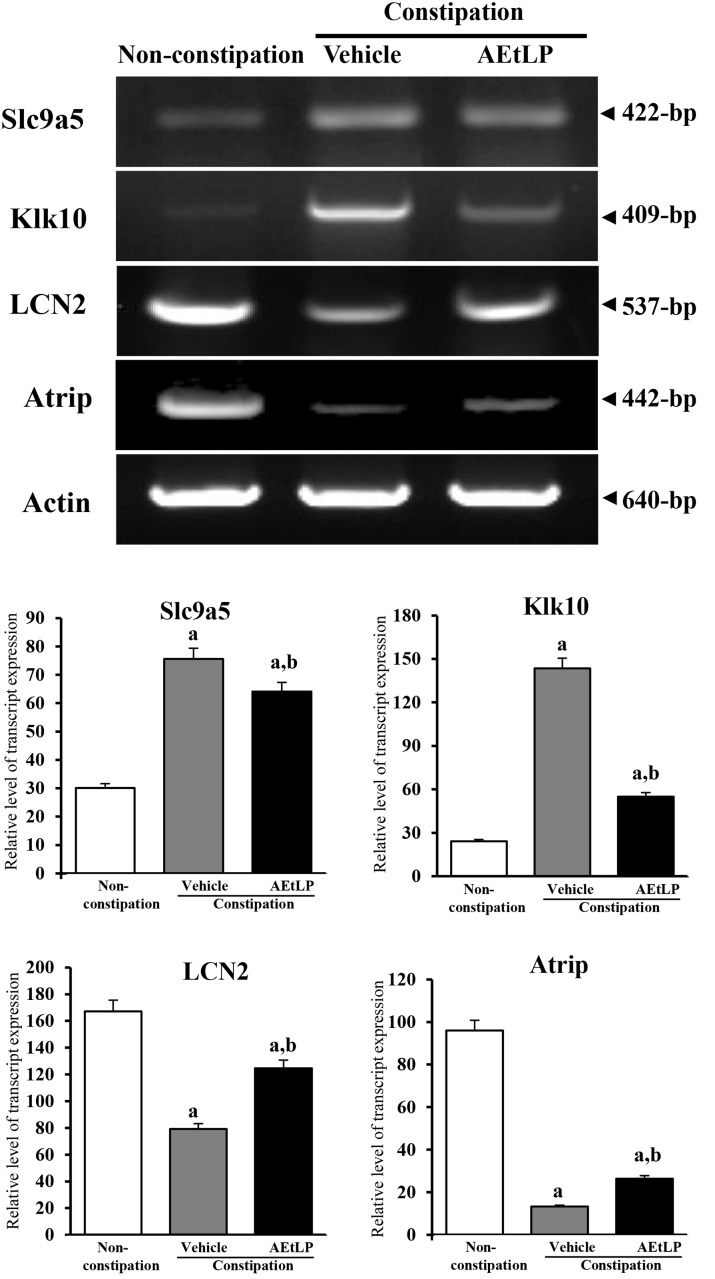
Change in the mRNA level of Slc9a5, Klk10, LCN2, and Atrip in non-constipation, vehicle- and AEtLP-treated constipation group.The distal colons of the rats in each group were pooled prior to mRNA analysis. The mRNA levels of the Slc9a5, Klk10, LCN2, and Atrip genes were examined by RT-PCR using the specific primers. The data shown are the means ± SD from three replicates. a, P<0.05 relative to the non-constipation group. b, P<0.05 relative to the vehicle-treated constipation group.